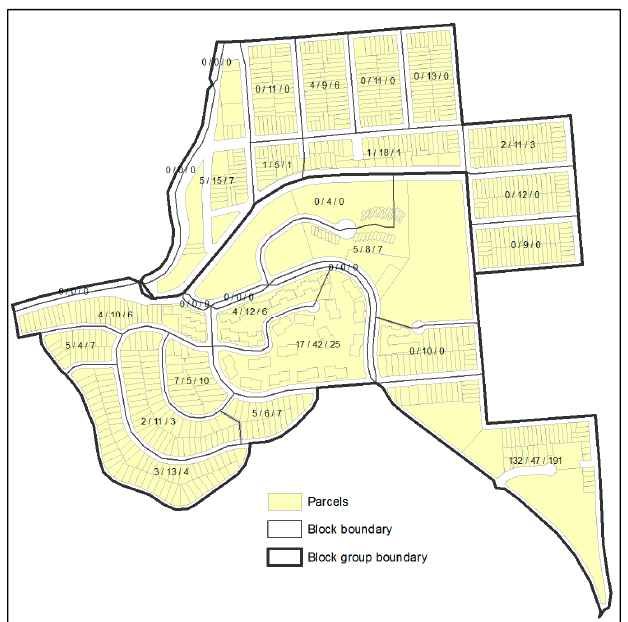
Figure 4. A case where the use of decennial census data results in improved accuracy. Parcel data are used to allocate 285 black residents to the blocks, with and without decennial census data. A label such as ‘132 / 47 / 191’ means the block has 132 black residents in 2010; it is estimated to have 47 black residents in 2013 when decennial data are used, and 191 when not.